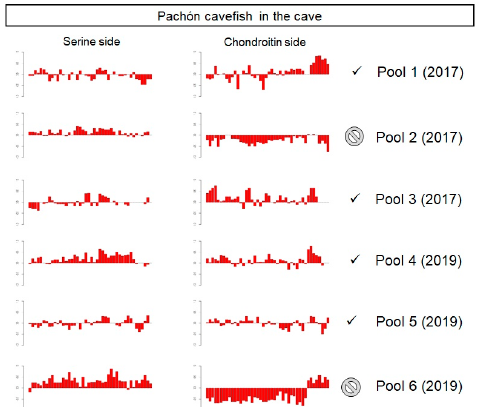
Figure 5. The place preference problem during cave experimentation. Graphs showing the position of the fish along the whole ~1 h protocol for the n = 6 experiments performed in the Pachón cave. The bars represent the preference of fish toward the serine perfusion side (left column) or the chondroitin perfusion side (right column). In theory, the eight fish should swim across the arena and distribute or explore randomly except for the response to the considered odor. However, in some instances (here, plastic pools 2 and 6), it was not the case: The fish remained in the same part of the plastic pool throughout the experiment, showing place preference for unknown reasons. These data were excluded from analysis.